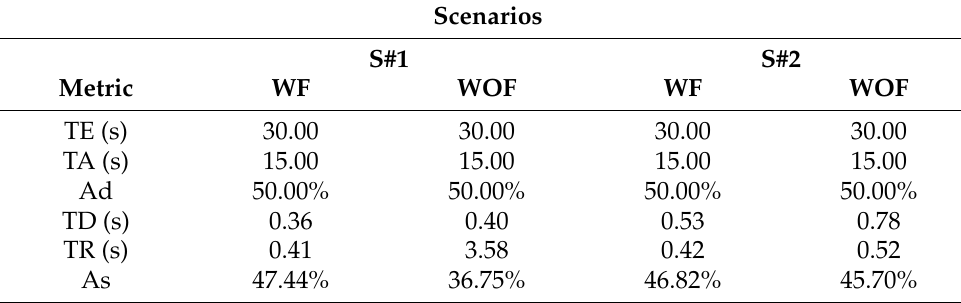
Table 6. System availability